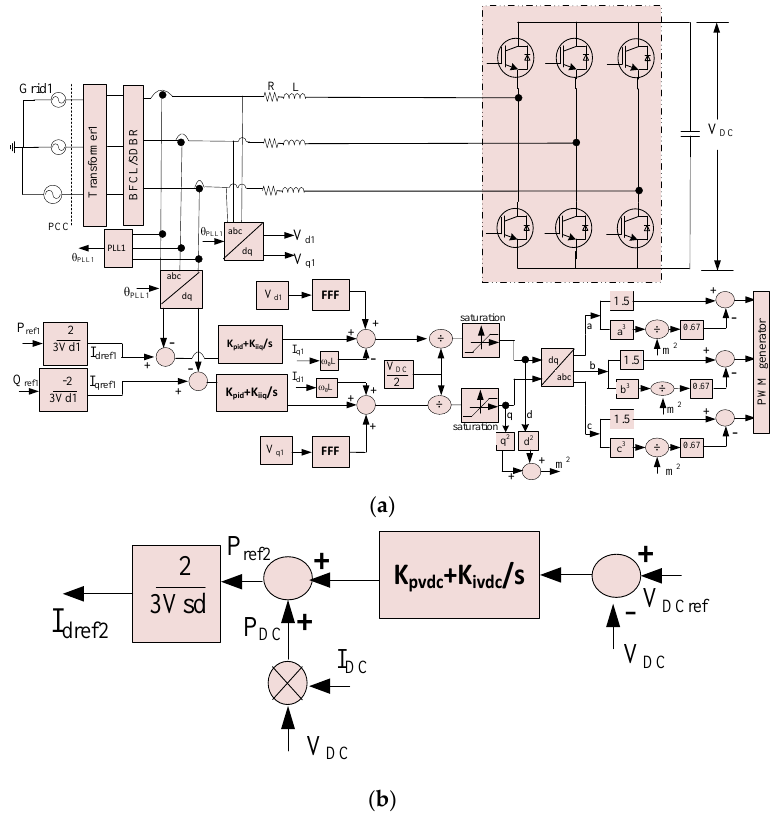
Figure 3. HVDC system controllers ( a ) VSC1 controller with BFCL/SDBR ( b ) VSC2 controller with BFCL/SDBR.